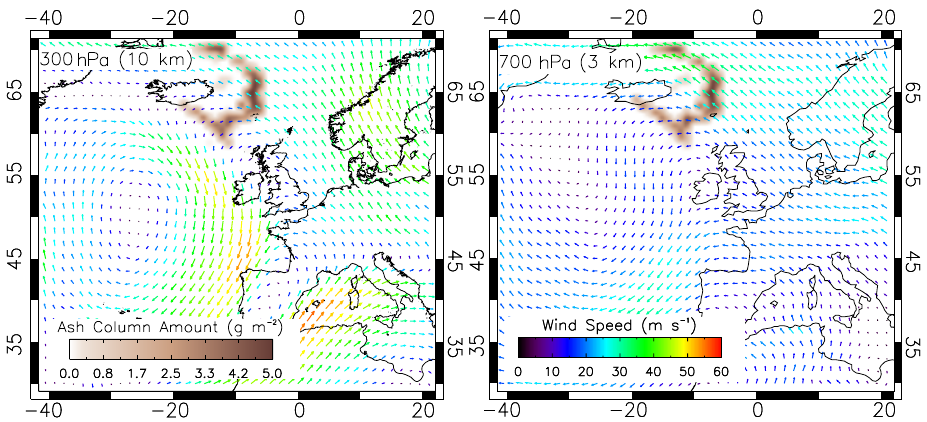
Figure 8: ECMWF windfield data for May 13 at 18:00 UTC for the Fig. 8. ECMWF windfield data for 13 May at 18:00 UTC for the 300hPa and 700hPa levels (approximately 10km and 3km respectively) with the coincident SEVIRI ash retrieval underlain. The windfield data shows a stronger southern component at high altitude with a stronger south-easterly windspeed at lower